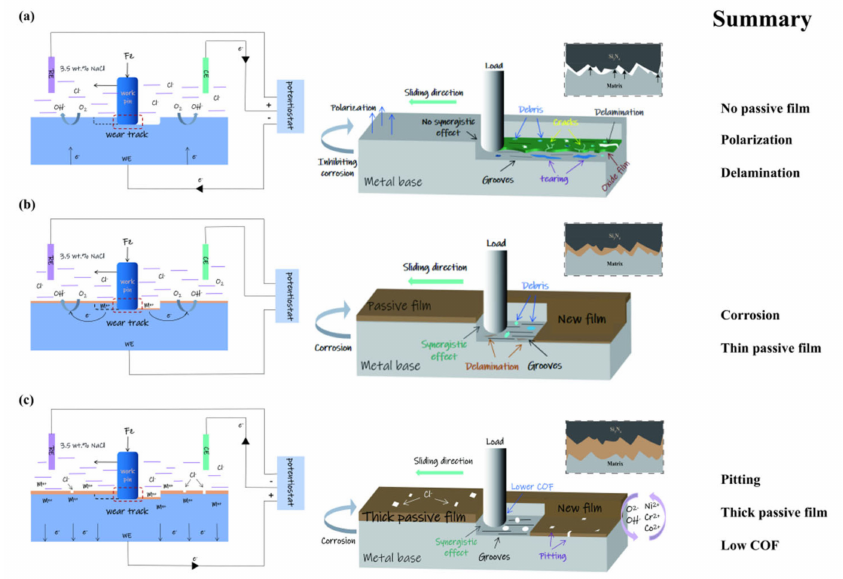
Figure 14. Schematic diagram of tribocorrosion mechanism at ( a ) cathodic polarization, ( b ) OCP, and ( c ) anodic dissolution state of CoCrNi alloy in 3.5 wt. %